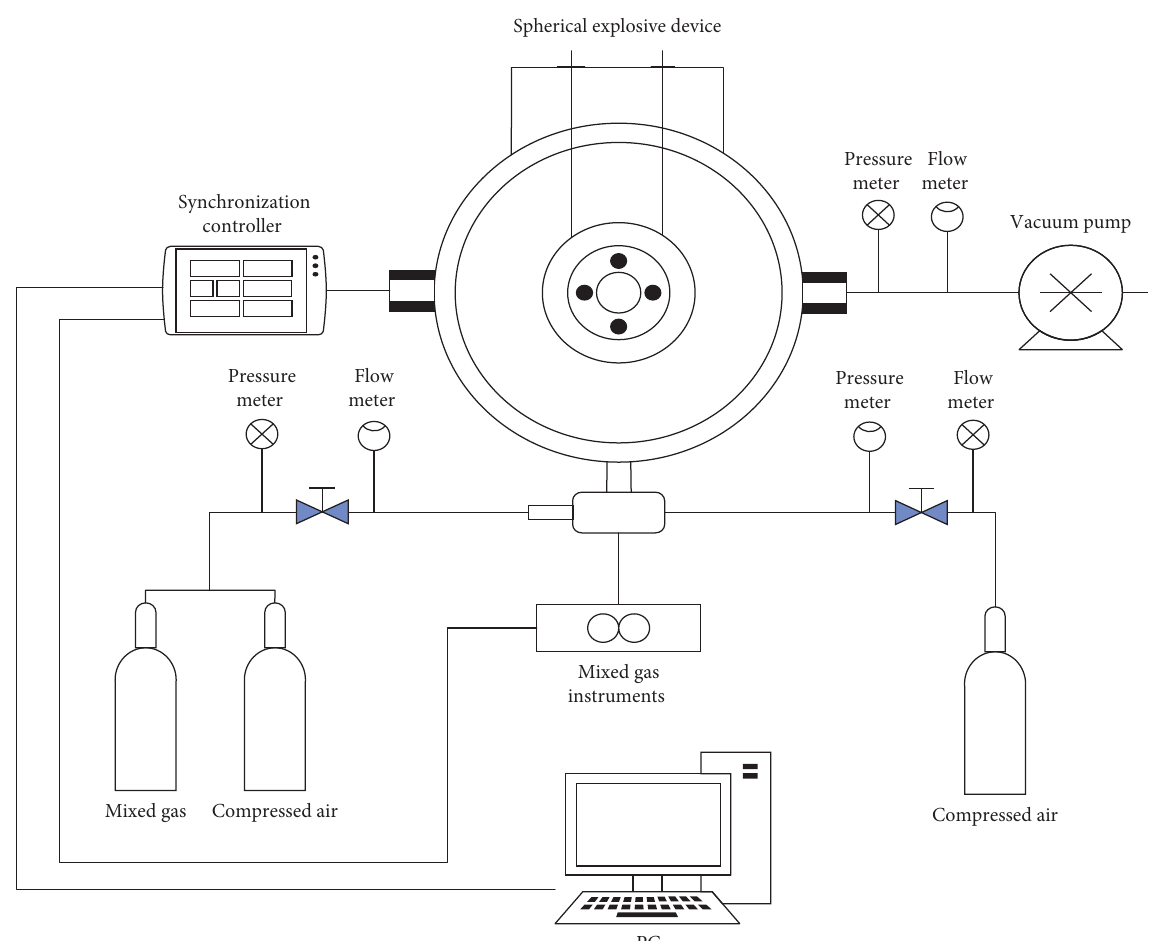
Figure 5: Explosion experiment